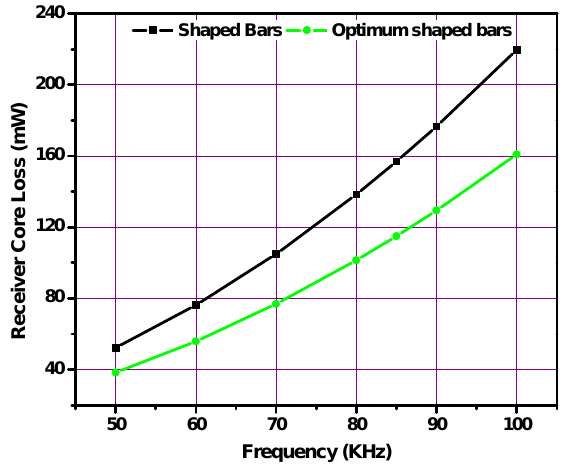
Figure 14. The Rx core loss vs. frequency for shaped bars and optimum shaped bars.